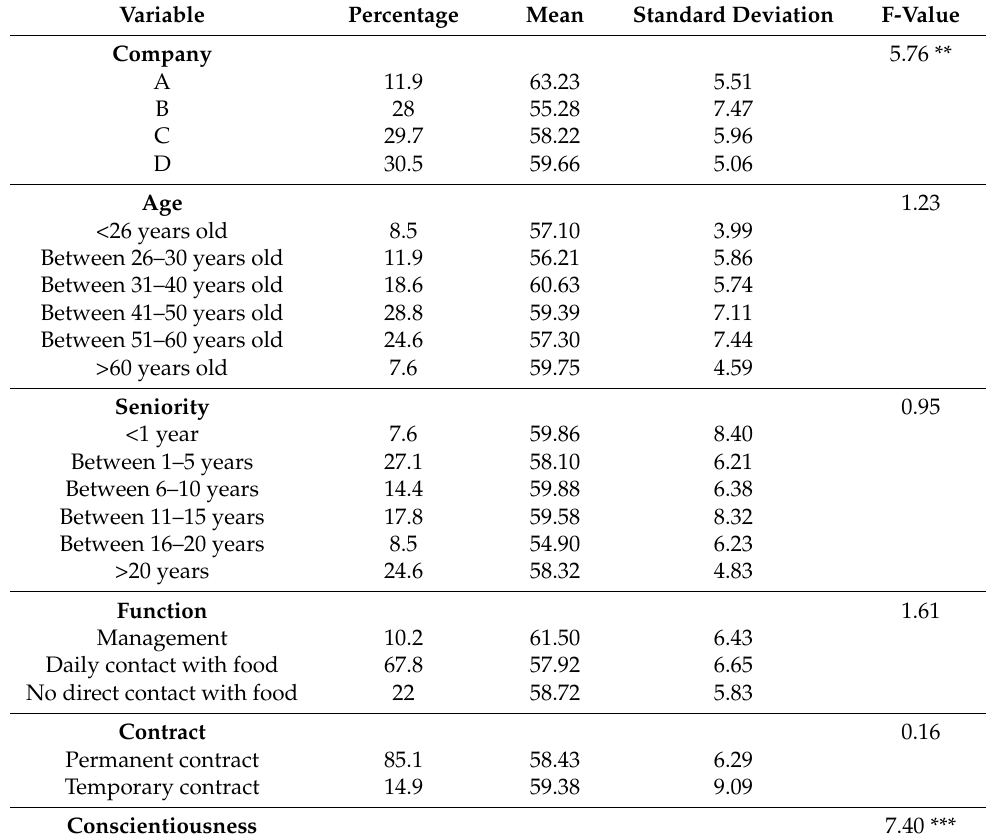
Table 1. Demographic analysis of the sample ( n = 118 participants) and relation between